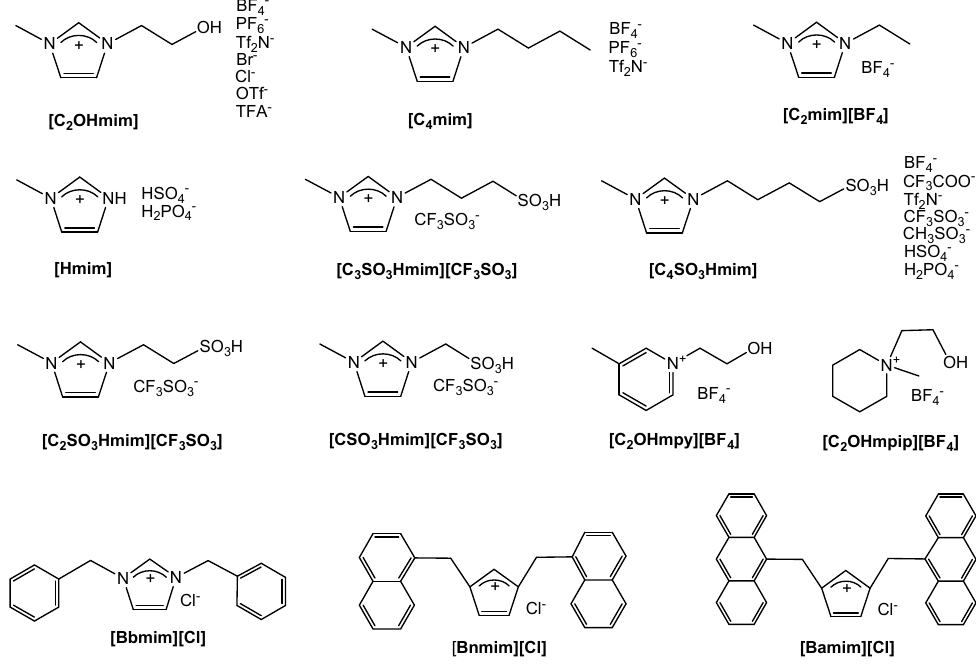
Figure 1. The structures and abbreviations of ionic liquids (ILs) described in this